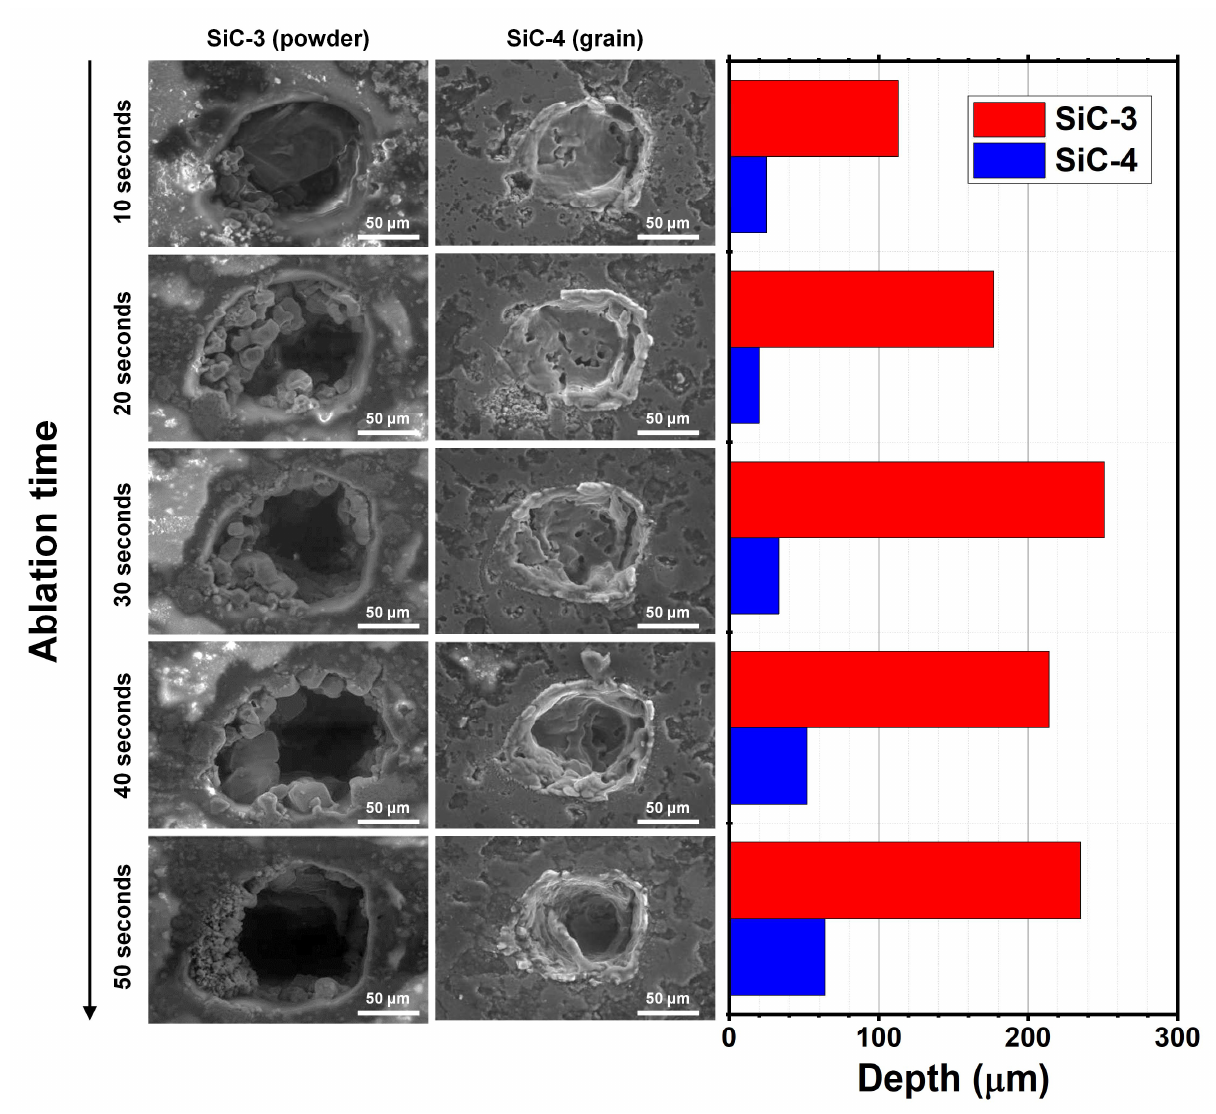
Figure 5. SEM images of craters generated by laser ablation spots on samples SiC-3 and SiC-4 using different ablation times. The bar plot shows the depth of the craters for both samples as measured by SEM.